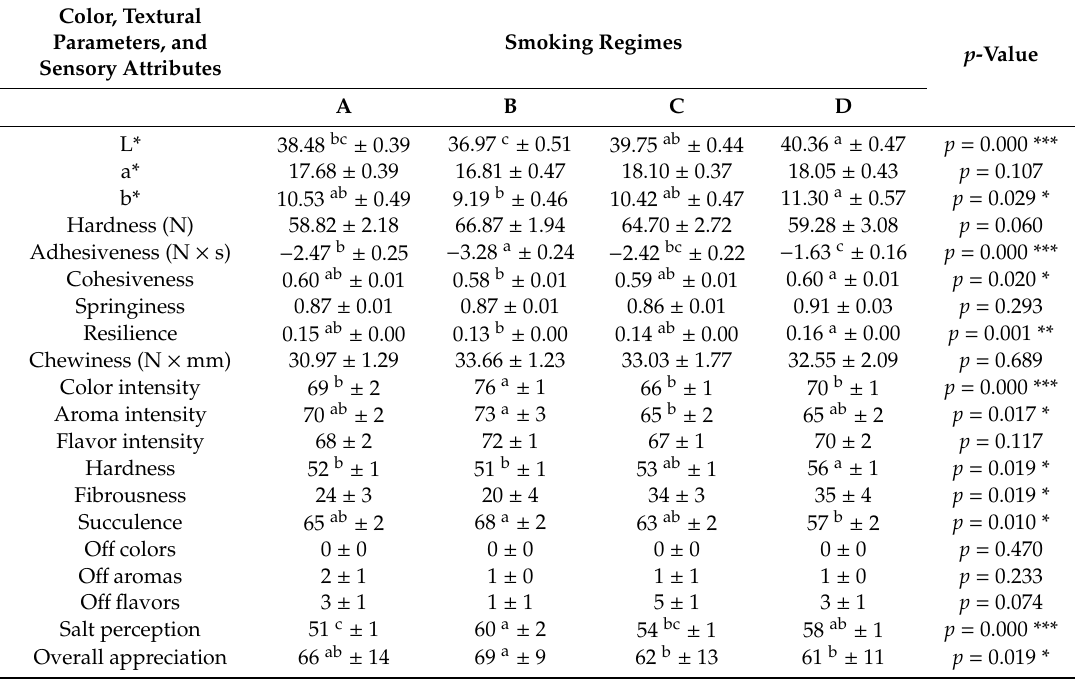
Table 2. E ff ect of smoking on color, textural parameters, and sensory attributes of dry-cured sausages. Color,